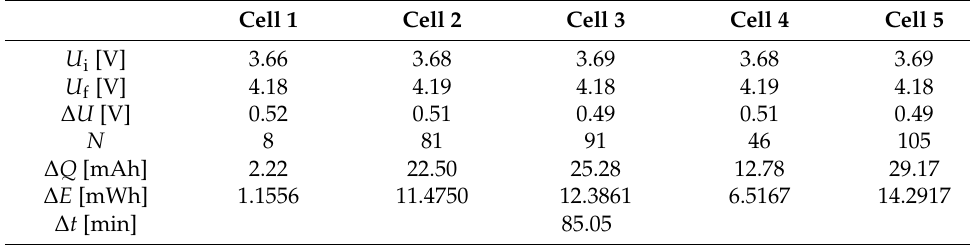
Table 4. Charge system configuration data.